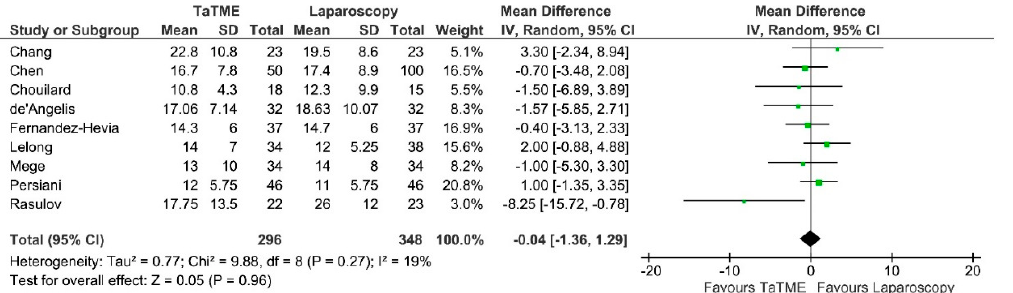
inverse variance.